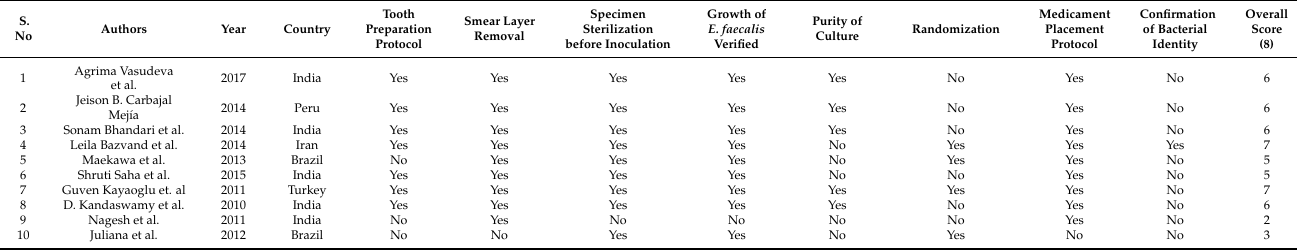
Table 3. Risk of bias assessment for included studies, based on standardization of reported factors. These included specimen preparation, smear layer removal, specimen sterilization, verification of E. faecalis growth, purity of the culture, randomized sampling, medicament placement protocol, and confirmation of bacterial identity after medicament